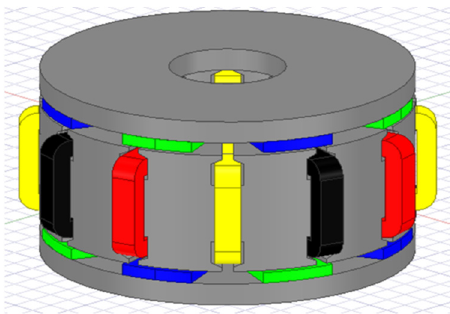
Figure 1. Original shape of the most qualified axial flux permanent magnet generator in [10].